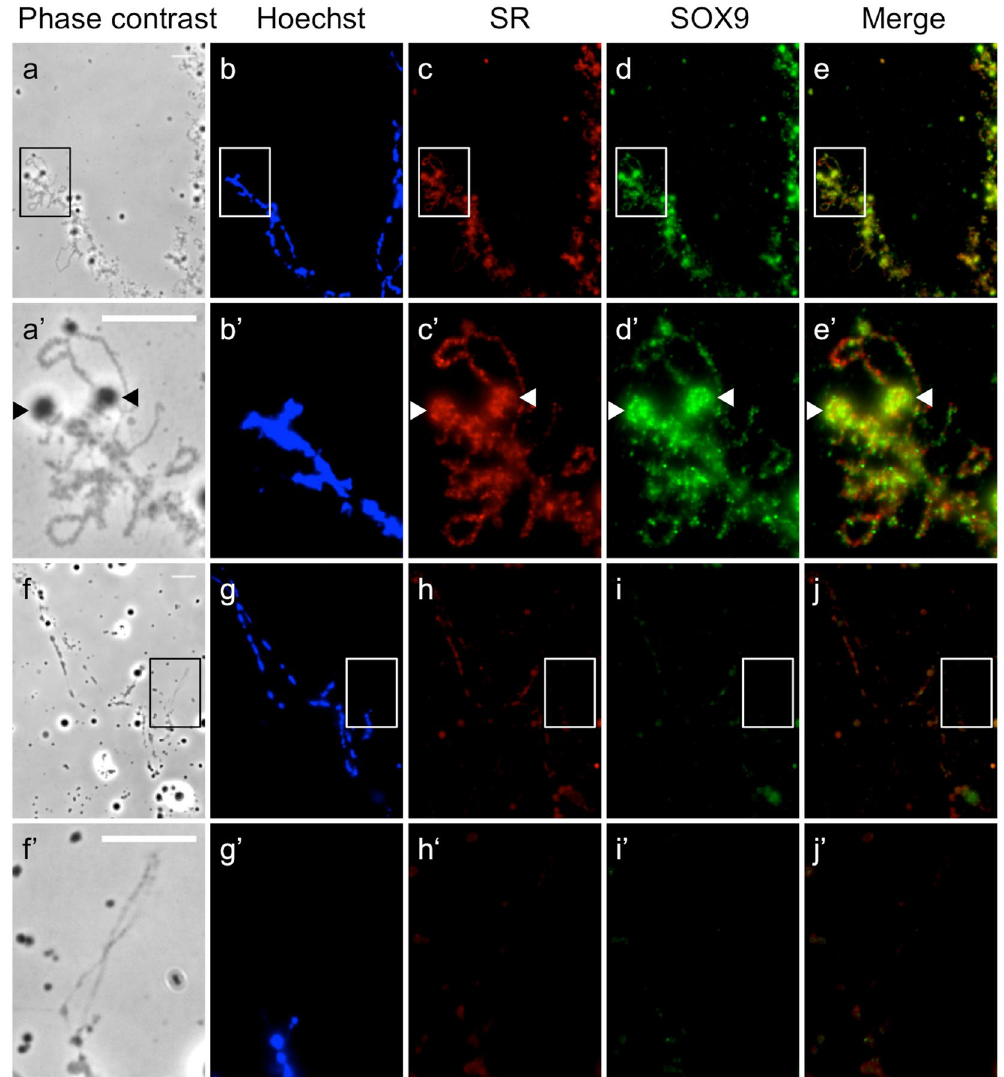
Figure 8. Localization of SOX9 to the matrix of lateral loops is RNA-dependent. Nuclear spreads of X. laevis were immunostained for SOX9 [anti-Cter-SOX9 antibody (green, Alexa 488 IgG)] and SR proteins [mAb1H4 (red, Alexa 568 IgG)]. ( a – e ’) LBC from untreated nuclear spreads. ( f – j ’) LBC from nuclear spread digested with RNase A before immunostaining. ( a ’– e ’) Enlarged images of the regions marked by white boxes ( a–e ) show several lateral loops immunostained with SOX9 and SR antibodies. The arrowheads point to terminal granules. ( f ’– j ’) enlarged images of the regions marked by white boxes ( f–j ) show one lateral loop not stained with SOX9 and SR antibodies after digestion with Rnase A. The intensity of fluorescence in the different experiments was normalized with respect to their relevant controls (the secondary antibodies only). Wide field Leica microscopy. Scale bar: 10 μ